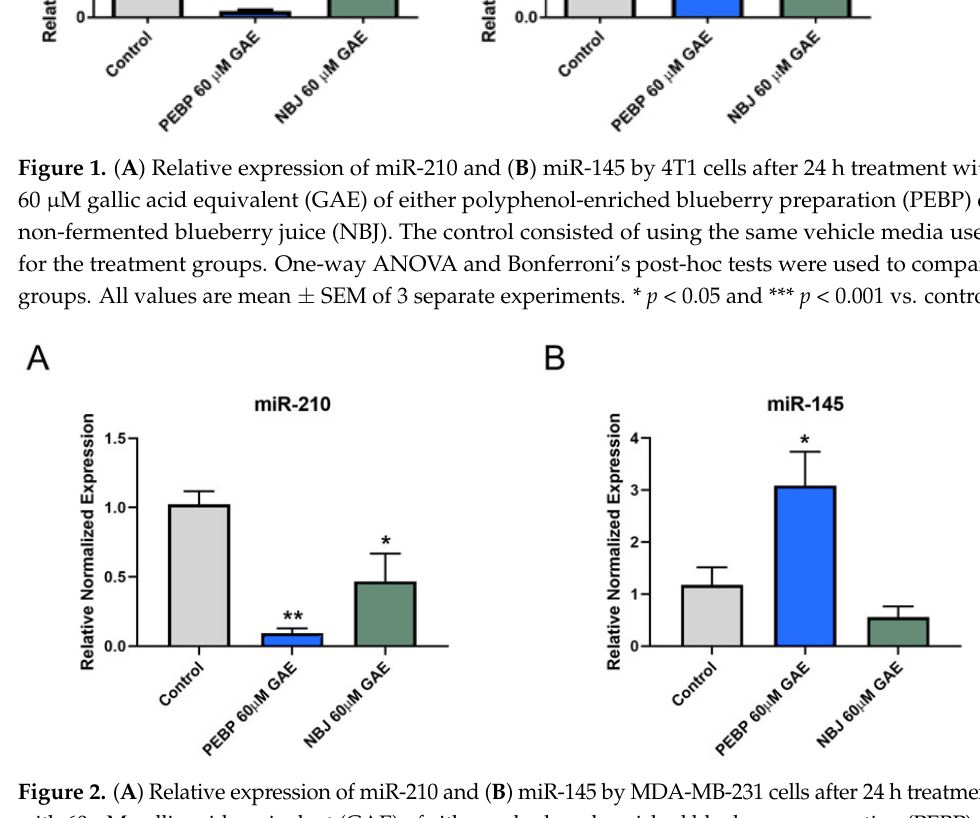
Figure 2. ( A ) Relative expression of miR-210 and ( B ) miR-145 by MDA-MB-231 cells after 24 h treatment with 60 µM gallic acid equivalent (GAE) of either polyphenol-enriched blueberry preparation (PEBP) or non-fermented blueberry juice (NBJ). The control consisted of using the same vehicle media used for the treatment groups. One-way ANOVA and Bon- ferroni’s post-hoc tests were used to compare groups. All values are mean ± SEM of 3 separate experiments. * p < 0.05 and ** p < 0.01 vs. control.